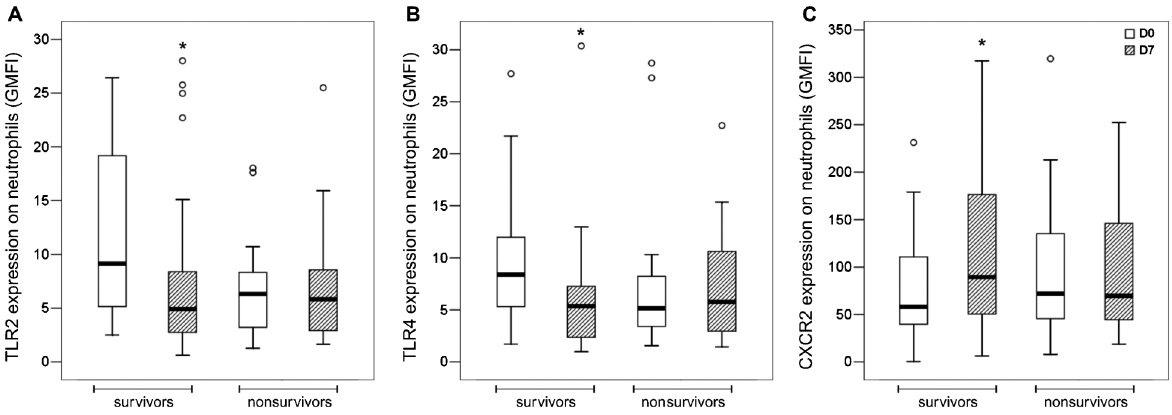
Figure 3. Expression of TLR2, TLR4, and CXCR2 surface receptors on neutrophils from surviving septic patients (n=29) and nonsurvivors (n=16) at D0 and D7. Surface marker expression was analyzed in histograms and reported as the geometric mean fluorescence intensity (GMFI): TLR2 ( A ), TLR4 ( B ) and CXCR2 ( C ). Data are reported as box plots, medians with 25 to 75% quartiles (box) and minimum and maximum values (bars). Empty circles indicate outliers. D: day. *P , 0.05 compared to D0 from the same group (Wilcoxon signed-rank